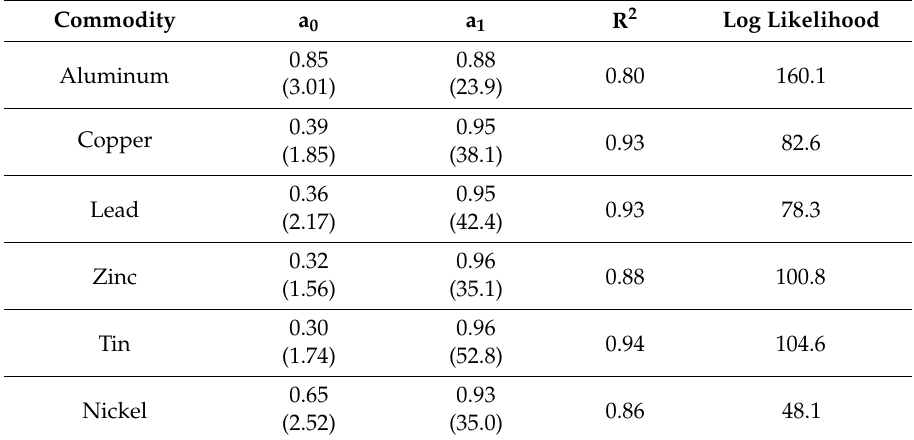
Table 6. GARCH parameter estimates of Equation (1): monthly data analysis.